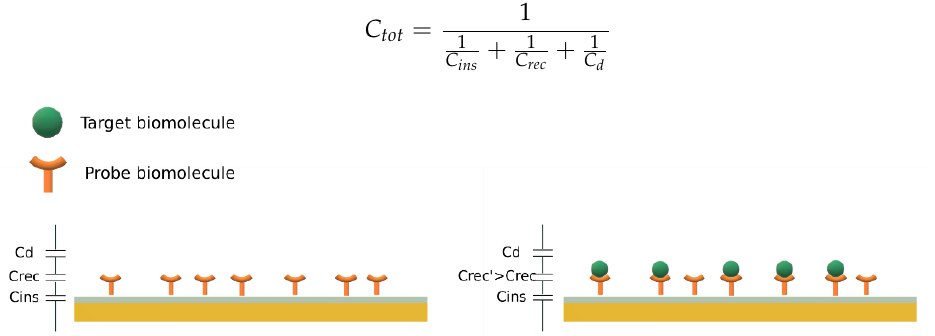
Figure 2. Schematic representation of electrode–solution interfaces for capacitive detection of biomolecules. C rec increases after capture of the target biomolecules.